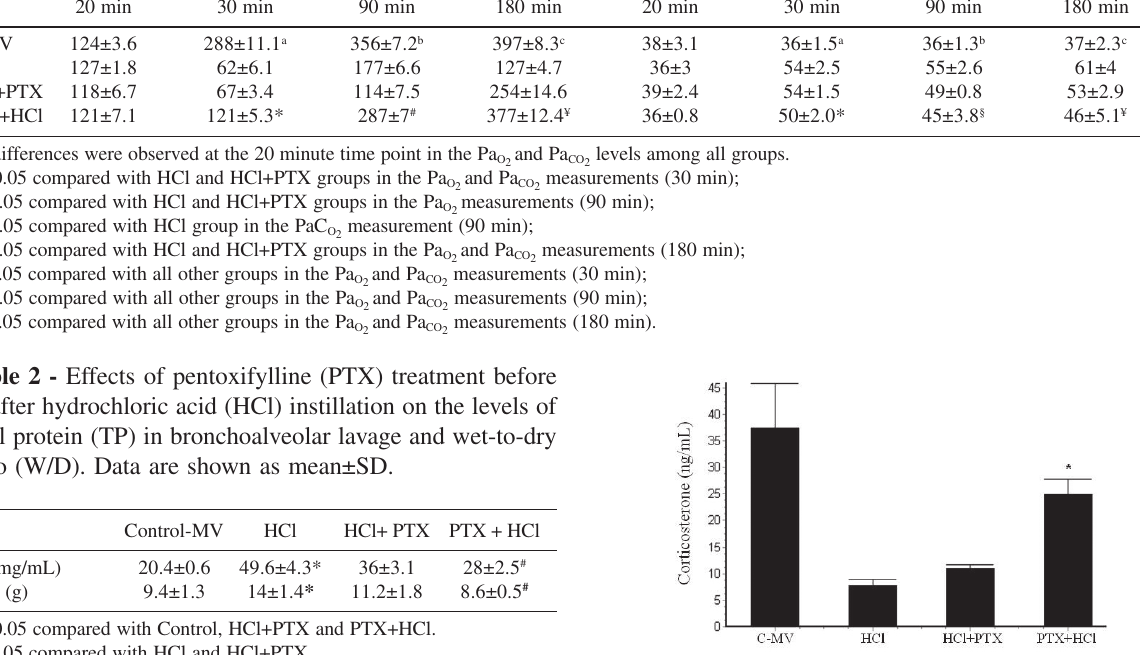
and Pa at 20, 30, O2 CO2